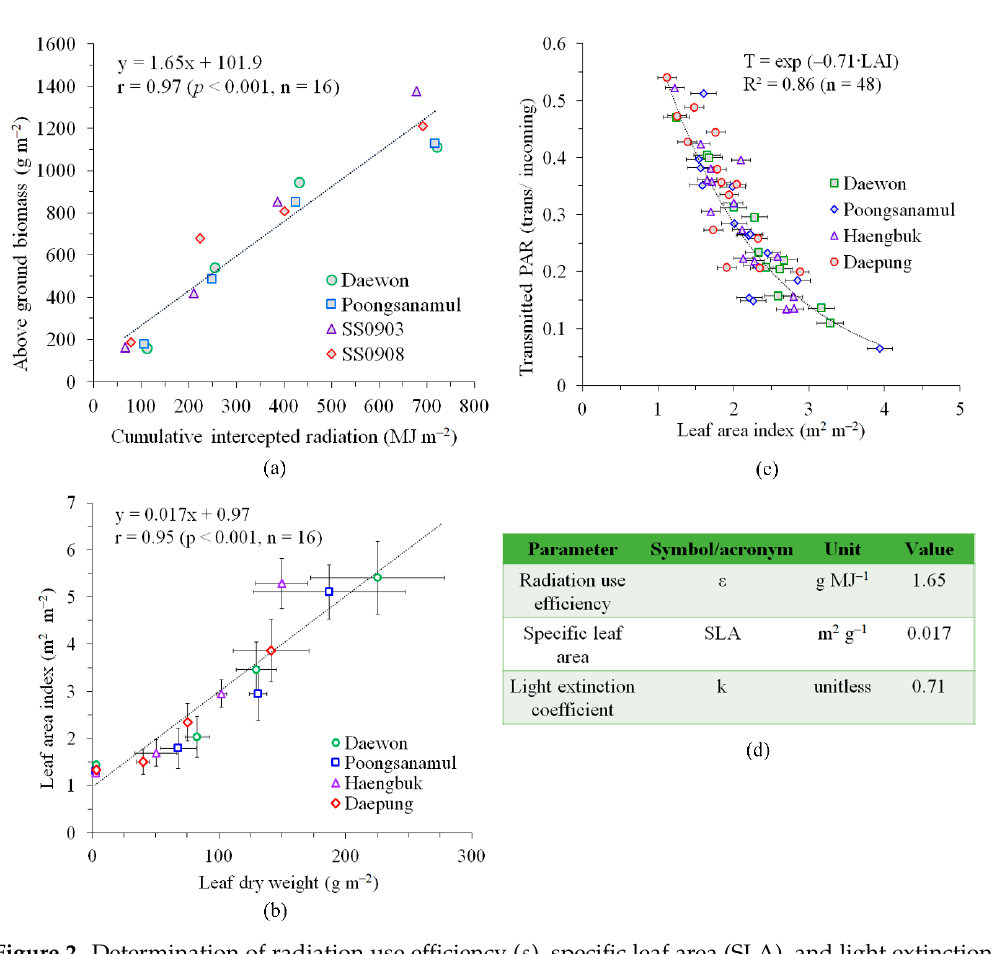
Figure 2. Determination of radiation use efficiency ( ε ), specific leaf area (SLA), and light extinction coefficient (k): ε estimated from the linear regression relationship between the amounts of accumulated photosynthetically active radiation (PAR) absorbed by soybean canopies and above- ground dry mass ( a ); SLA from the linear regression relationship between leaf area index and leaf dry weight ( b ); k derived from the exponential regression between transmitted and incoming PAR (T) and leaf area index, LAI ( c ); and determined values of ε , SLA, and k ( d ). The data were obtained for four germplasms or cultivars at Chonnam National University, Gwangju, South Korea, in 2017. Horizontal and vertical error bars in the panels ( b ) and ( c ) represent ±1 SD of the corresponding mean values, and r is Pearson’s correlation coefficient .